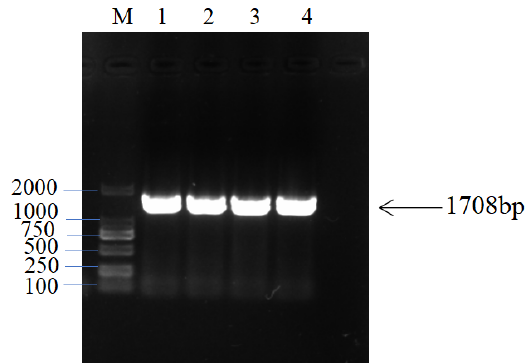
Figure 3. HbNHX1 Clones. Note: M = Marker (2000 bp; 1). 2, 3, and 4 are HbNHX1 genes.